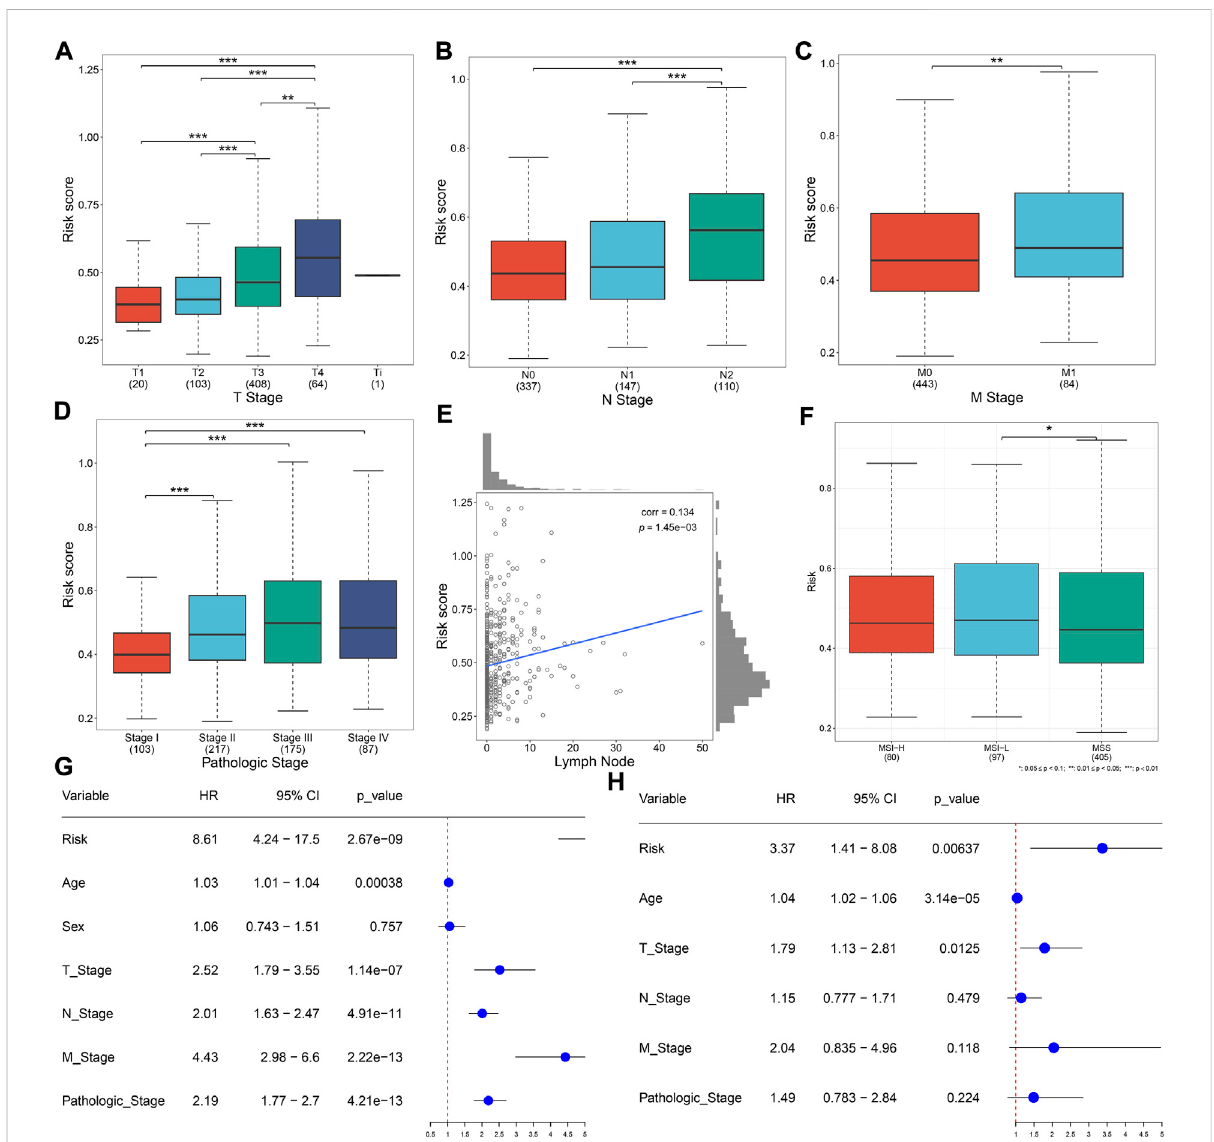
FIGURE 3 Oxidative stress-related gene signature correlates to clinical characteristics and serves as an independent prognostic factor in TCGA CRC. (A – D) Distribution of the risk score derived from the oxidative stress-related gene signature across (A) T, (B) N, (C) M, and (D) pathological stage. (E) Scatter plot of the correlation between the risk score and lymph node. (F) Distribution of the risk score across different microsatellite status. (G,H) Forest plots of the uni- and multivariate Cox regression results. * p < 0.05; ** p < 0.01; *** p < 0.001. N =